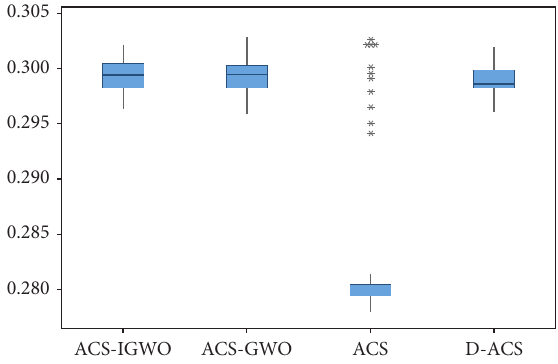
Figure 10: Box plot of example II.